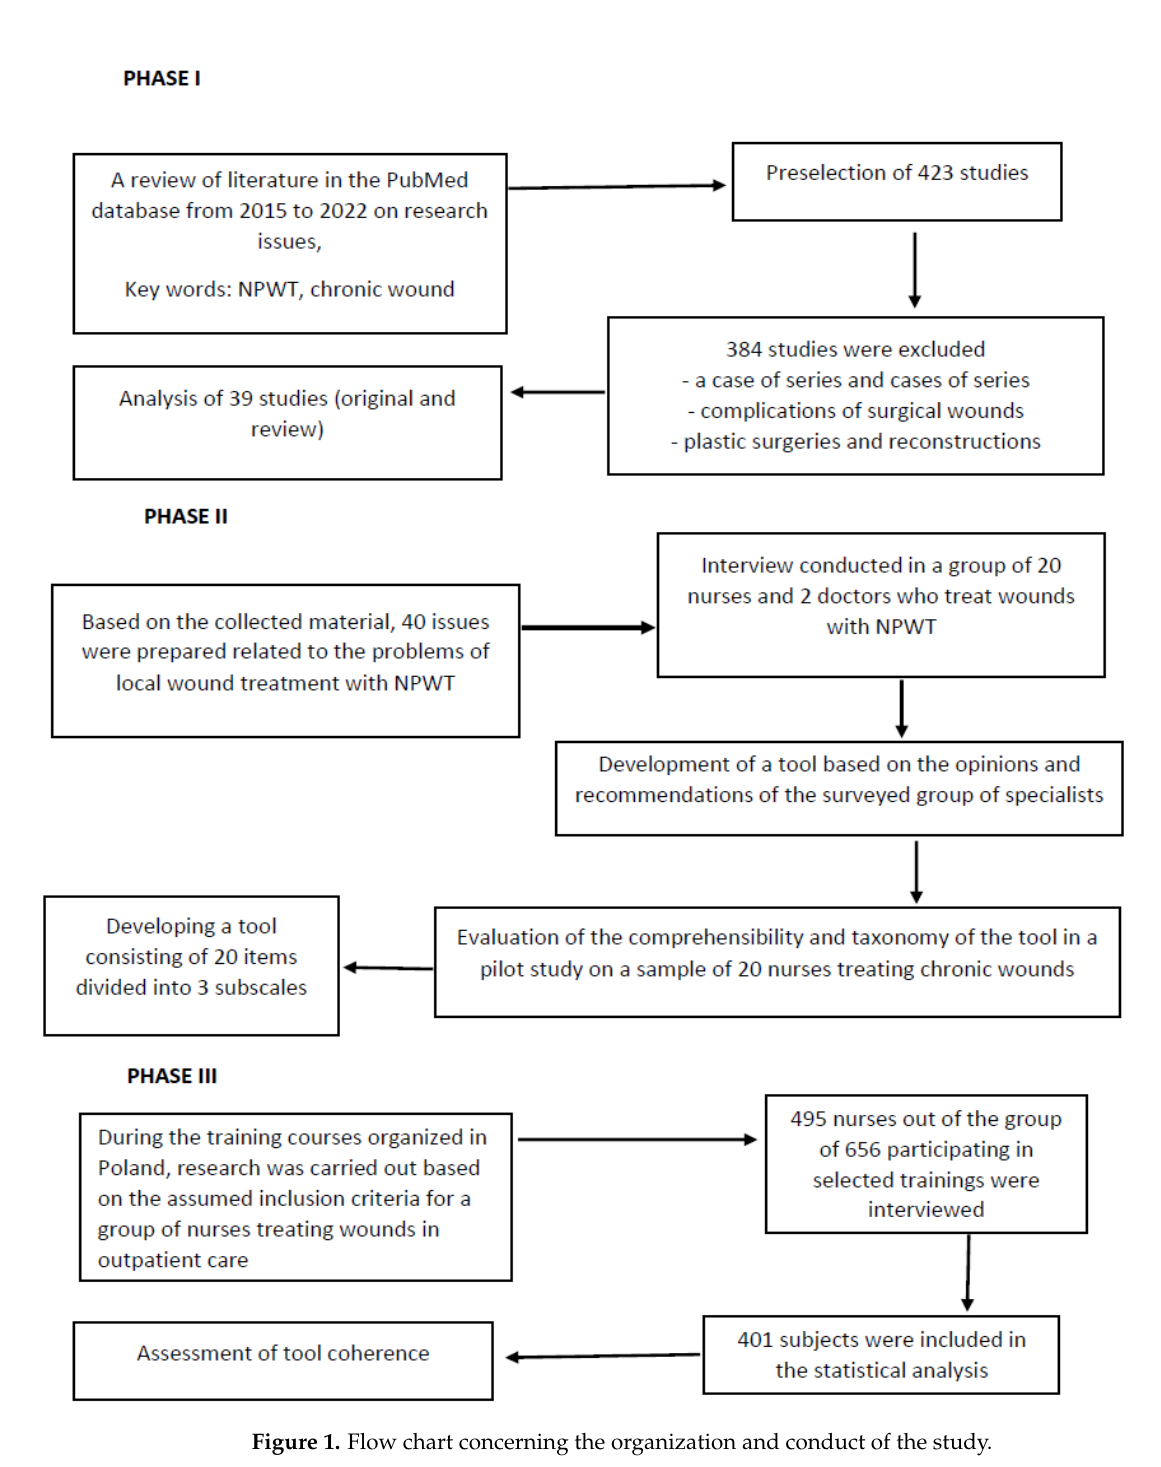
Figure 1. Flow chart concerning the organization and conduct of the study .